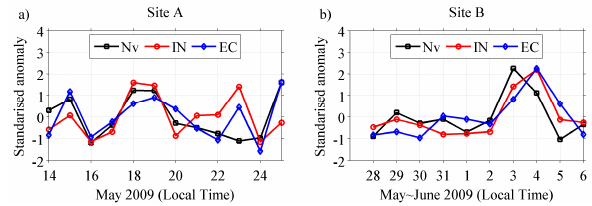
Figure 15: Time series of standardized anomalies of afternoon mean volume concentration (Nv) , inorganic species (IN) and elemental carbon (EC). The mean volume concentration at night was not used due to some missing values.